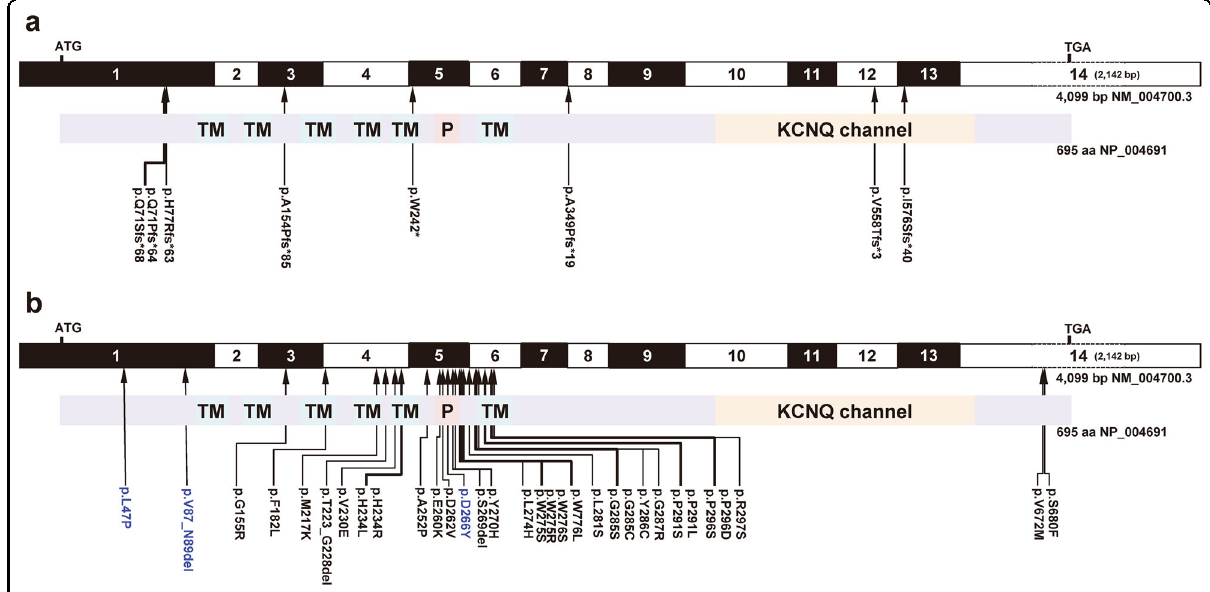
Fig. 1 Autosomal dominant non-syndromic hearing loss (DFNA2)-associated KCNQ4 variants. a Exon structure of human KCNQ4 cDNA and domain structure of KCNQ4 are shown. Only variants identi fi ed in individuals with DFNA2 are shown. KCNQ4 contains 14 exons; the positions of the start (ATG) and stop (TGA) codons are indicated. Loss-of-function mutations, such as nonsense and frameshift mutations, are indicated. b Missense and in-frame deletion mutations are indicated. Note that mutations are clustered in exons 5 and 6, which encode part of the transmembrane (TM) 5, pore region, and TM6. The pathogenic variants identi fi ed by our group are shown in